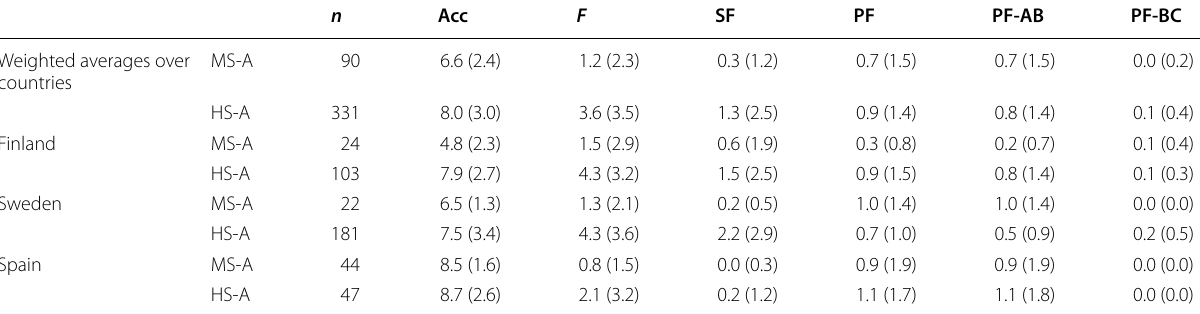
Table 3 Summary of key variables (mean and standard deviation) related to flexibility, for high-achieving students in Finland, Sweden and Spain